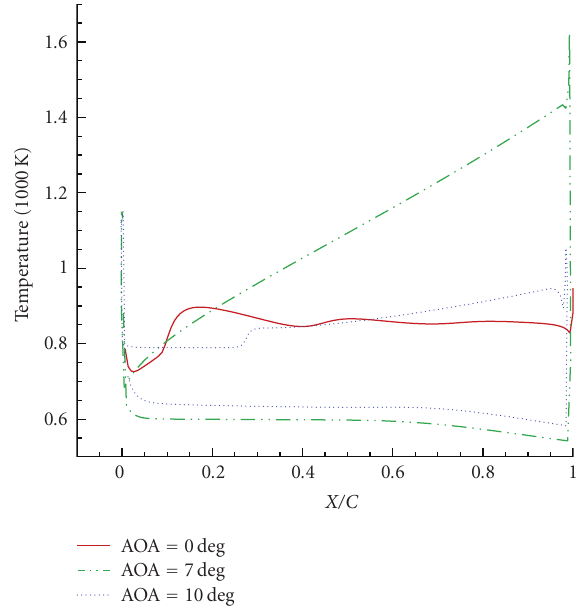
Figure 8: Temperature profile of HTPB surface at di ff erent AOA (C: length of the HTPB slab).